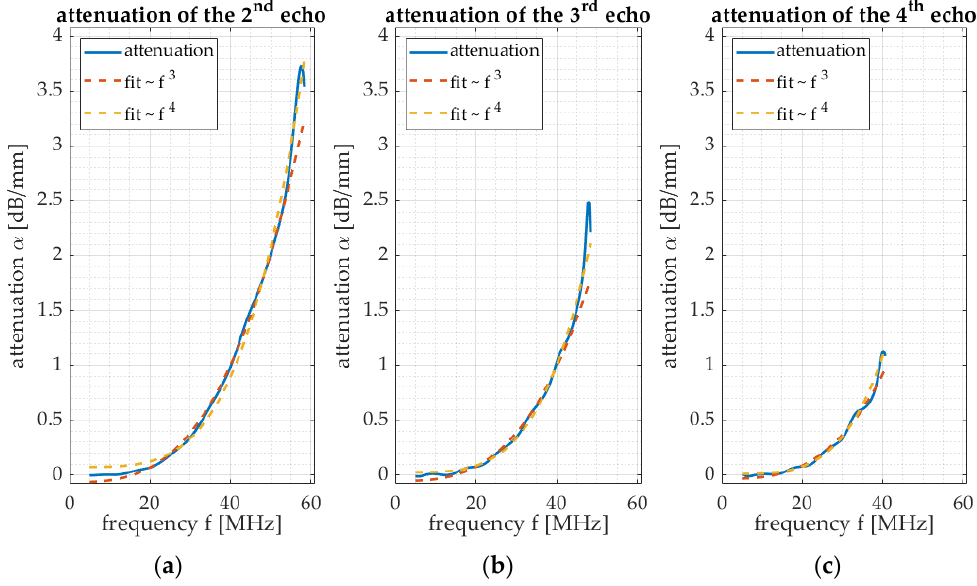
Figure 10. The attenuation curves of respectively ( a ) the second echo; ( b ) the third echo; and ( c ) the fourth echo normalized to a reference sample. For each curve, two polynomial fits 𝛼 = 𝑎 + 𝑏𝑓 𝛾 are overlaid for both 𝛾 = 3 and 𝛾 = 4 .